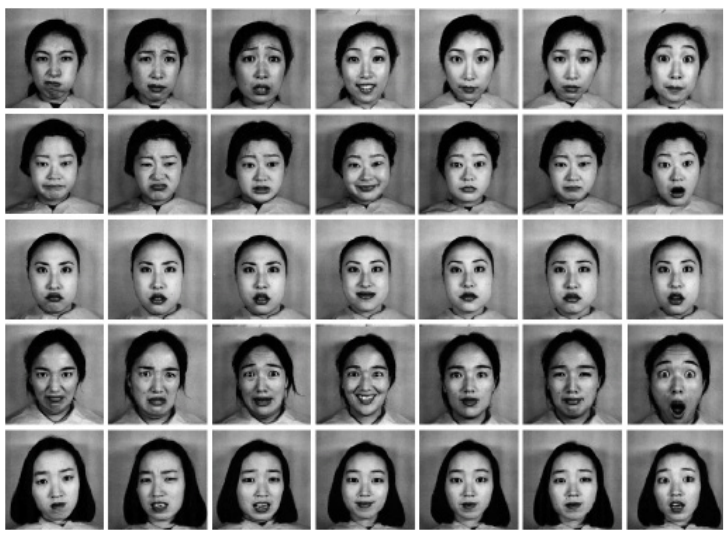
Figure 3. Examples of facial expression images from the JAFFE